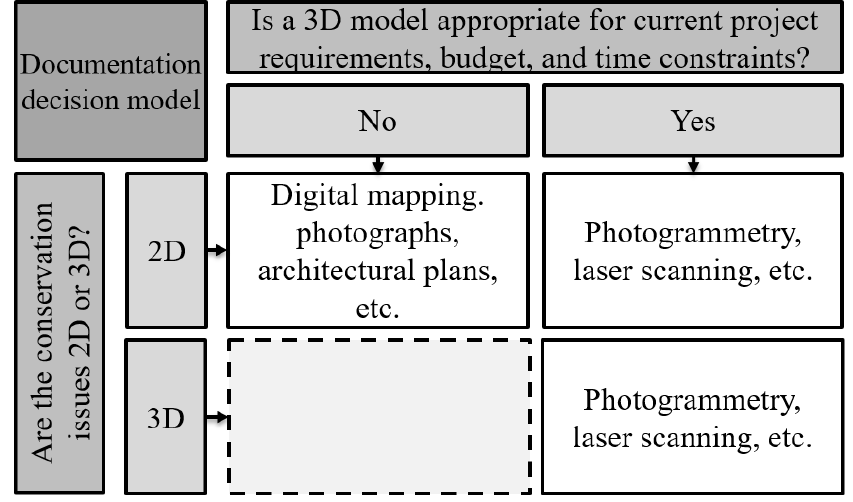
Figure 3. Gap in current methods for efficient documentation of conservation challenges